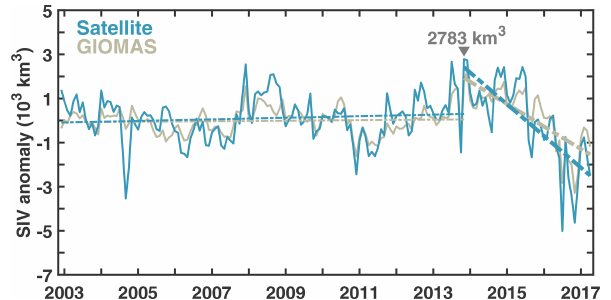
Figure 6. The SIV anomalies of satellite (green) and corresponding GIOMAS (khaki) observations. The dashed lines denote the linear trends in SIV anomalies from December 2002 to November 2013 and from November 2013 to April 2017. The bold dashed lines indi- cate that the linear trends have passed an F test at 99% significance level.